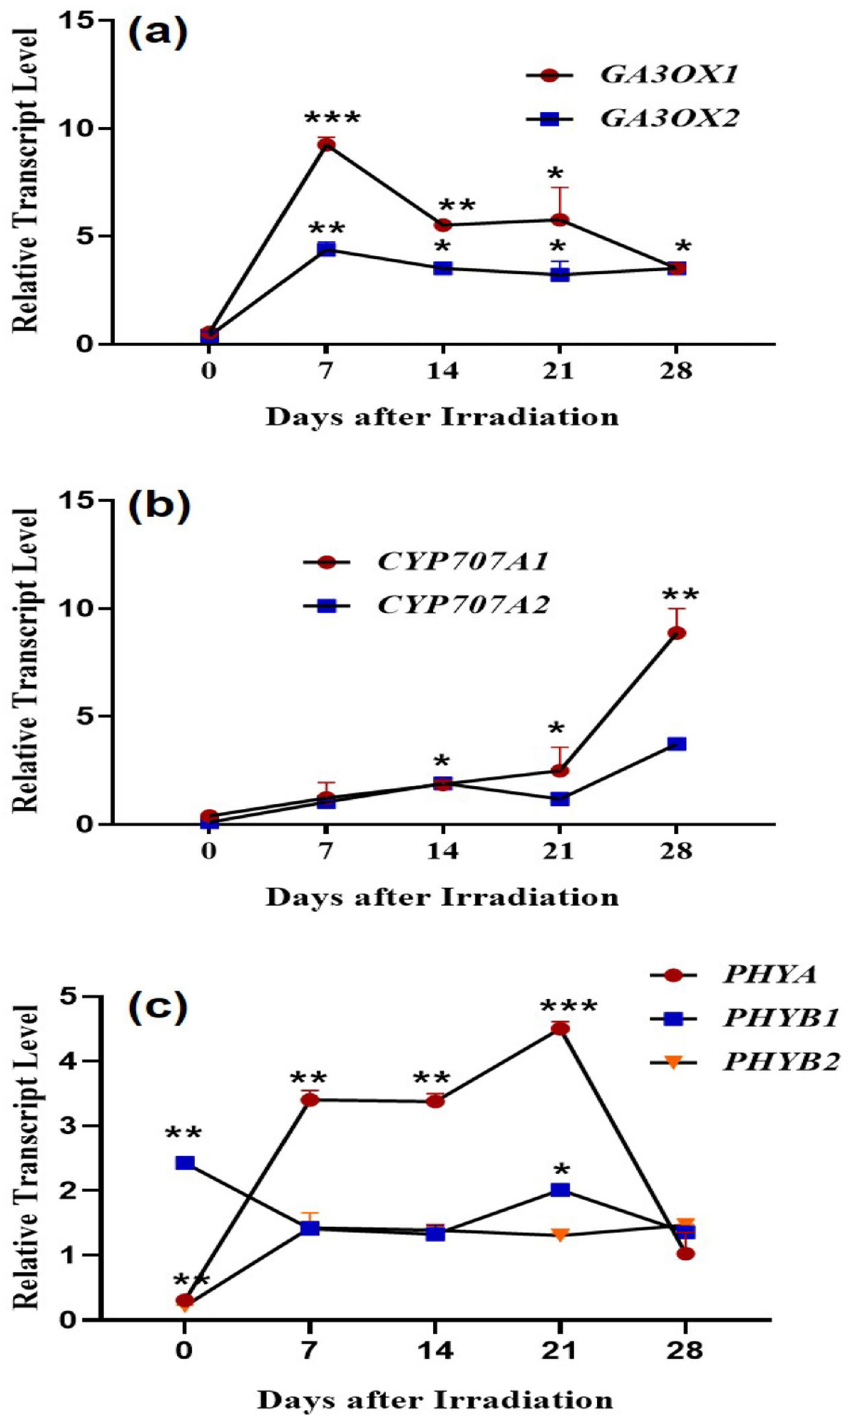
Figure 2. Expression of the genes involved in ( a ) gibberellic acid biosynthesis ( GA3ox1 and 2 ) ( b ) ABA inactivation ( CYP707A1 and –2 ) and ( c ) phytochrome regulation ( PHYA, B1 and B2 ) from seeds and seedlings of brinjal ( Solanum melongena L.) var. Mattu Gulla in response to He–Ne laser irradiation and un-irradiated control during 0–28 DAI. The transcript level represented are normalized to 18S rRNA and significant at *** p < 0.001, ** p < 0.01, and * p < 0.05 compared with un-irradiated control (n =